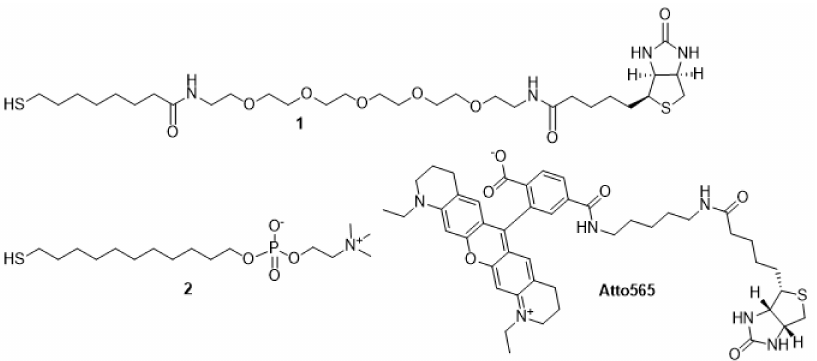
Figure 2. Structure of thiols 1 – 2 used for the passivation of the AuNPs and of the fluorescent biotinylated dye